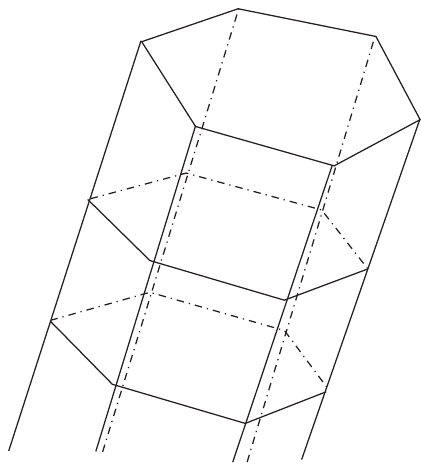
Figure 1: Graph of TUC